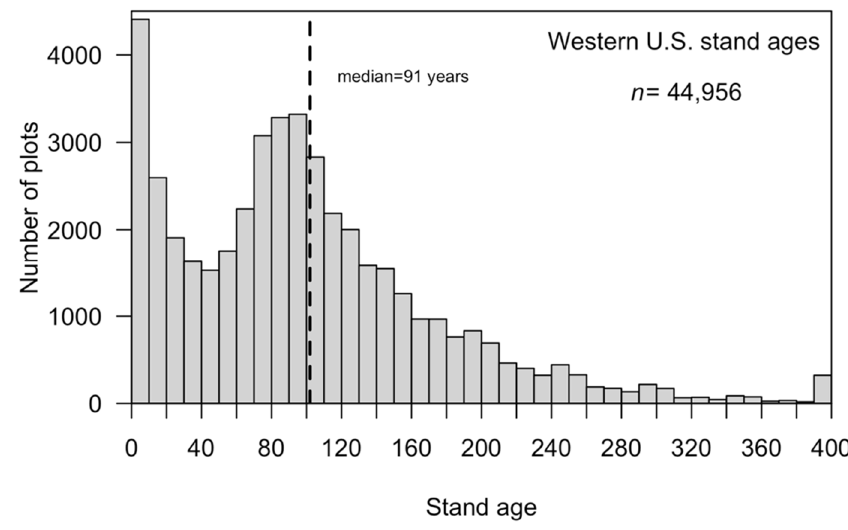
Figure 1. Stand age structure for forest land in the western United States. Data from a full cycle (2006–2015) of Forest Inventory and Analysis [13].